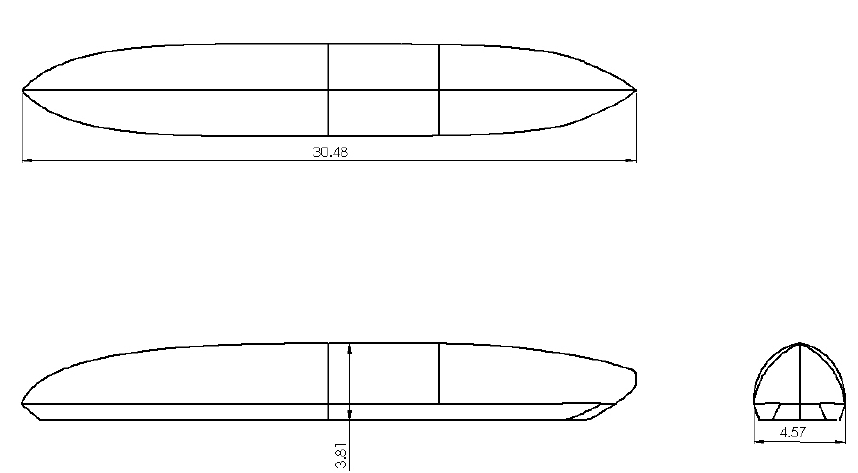
Figure 3. The overall dimensions of the Hyperloop pod used in this study. All lengths are in m.